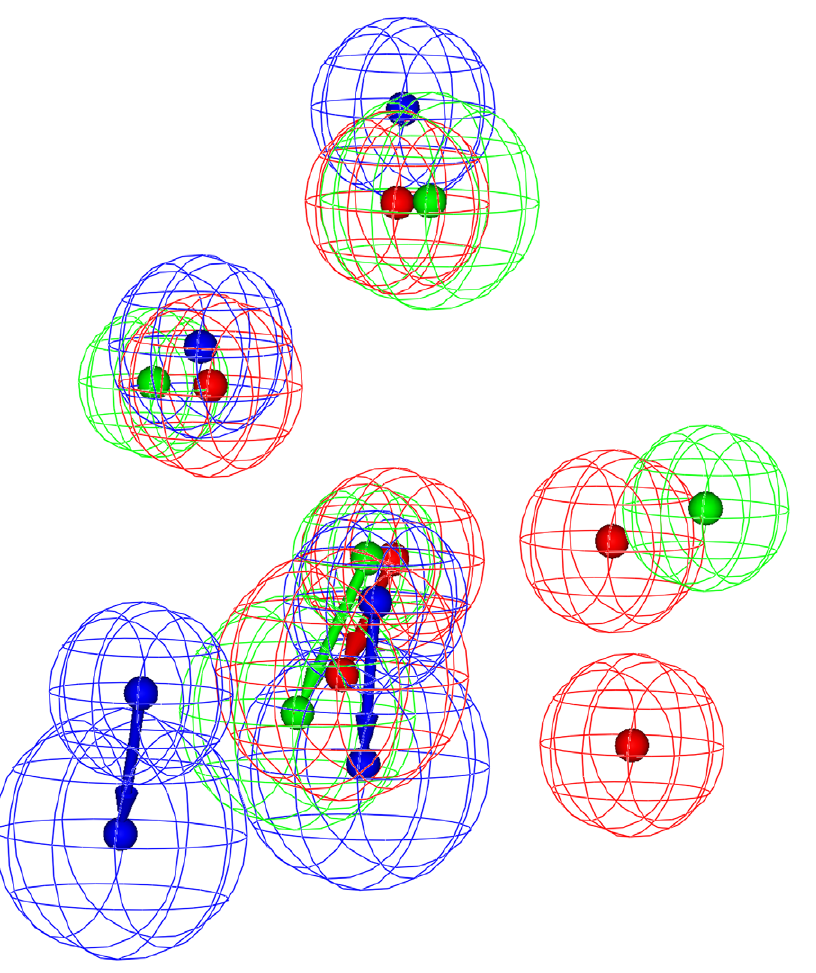
Figure 3. Superposed pharmacophore models. Superposition of three pharmacophore models Hypo A, Hypo B and Hypo C, denoted in red, blue and green, respectively.